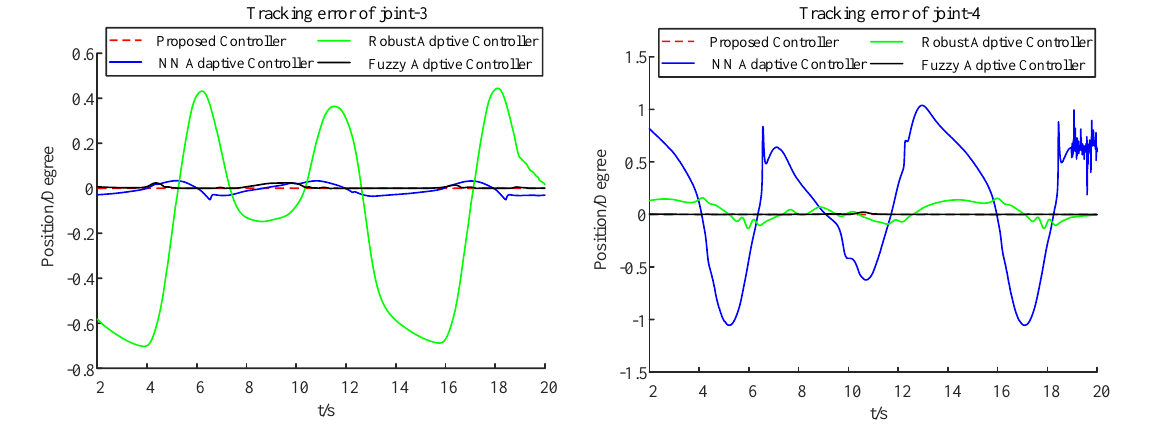
Figure 7. Trajectory tracking under different methods.